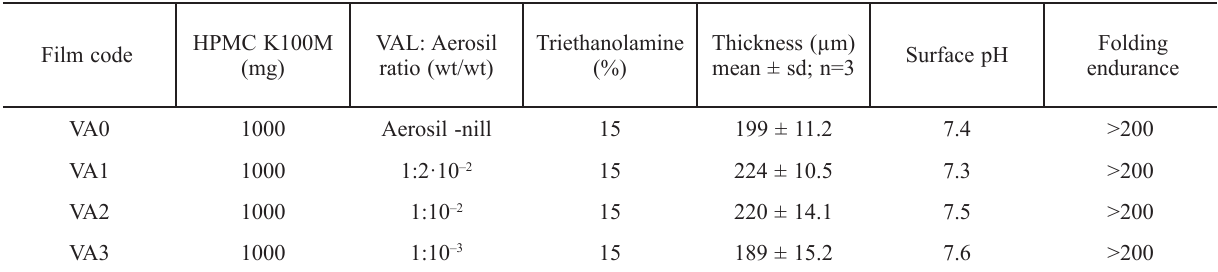
Table 1 – Formulation and physicochemical properties of valsartan film for buccal delivery Film